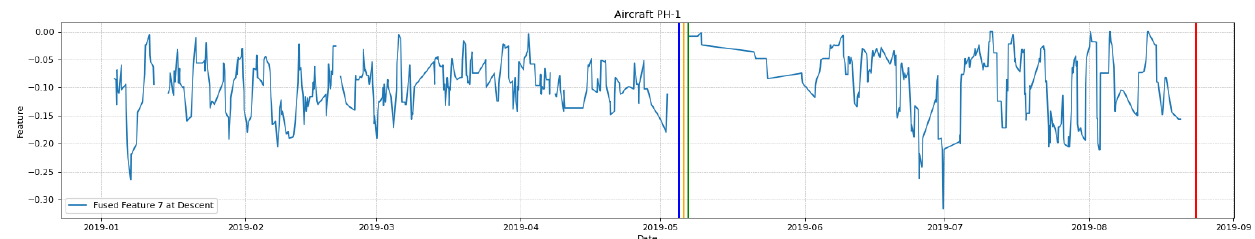
Figure 10. Fused feature 1 at Descent of aircraft